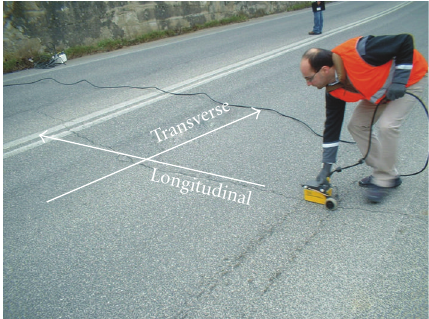
Figure 3: GPR acquisition in the road pavement site with 1600 MHz